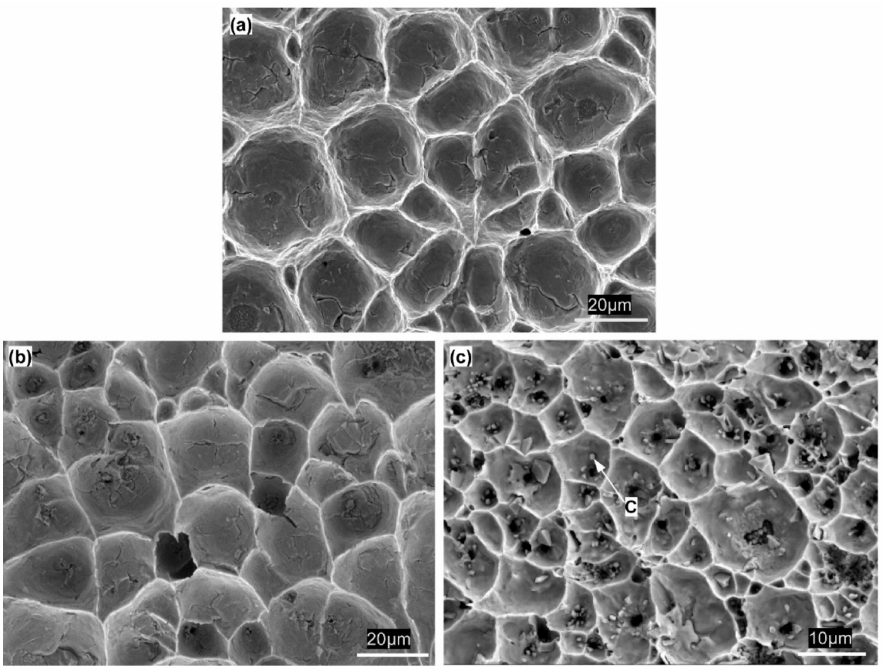
Figure 7. Fracture morphology of micro-joints with ( a ) 10%, ( b ) 20%, and ( c ) 40% IMC after tensile